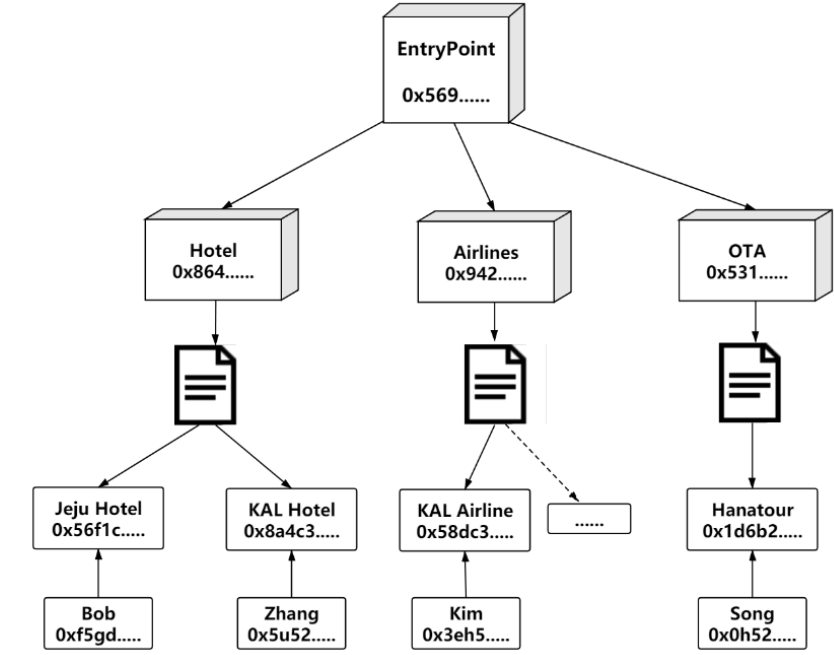
Figure 12. Smart contract architecture in Winding Tree Network.